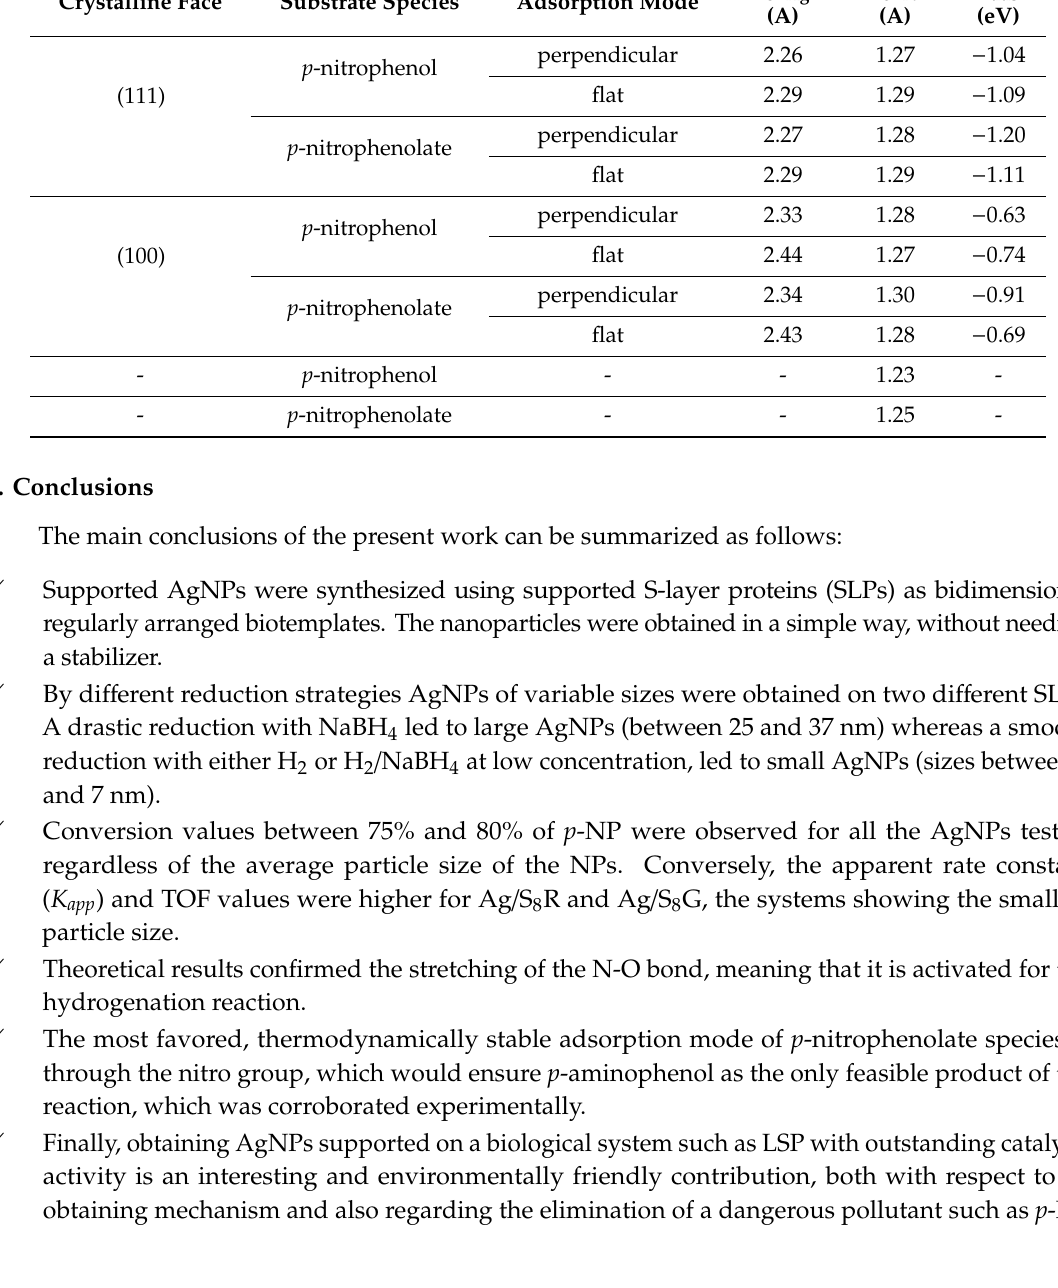
Table 2. Calculated O–Ag ( l O–Ag ) and O–N ( l O–N ) bond length and adsorption energies ( E ads ). Crystalline Face Substrate Species Adsorption